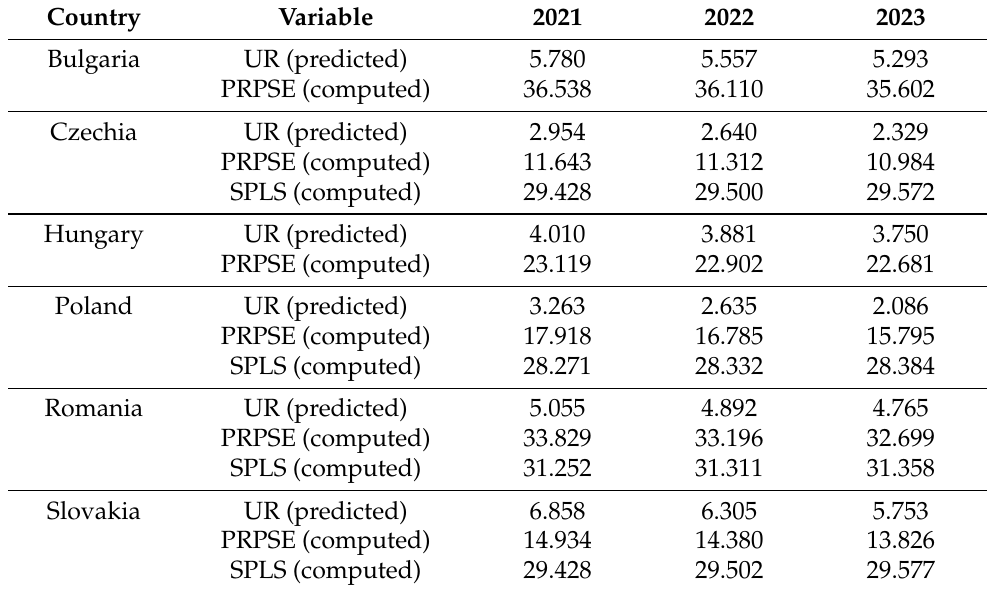
Table 6. The point prediction of PRPSE and